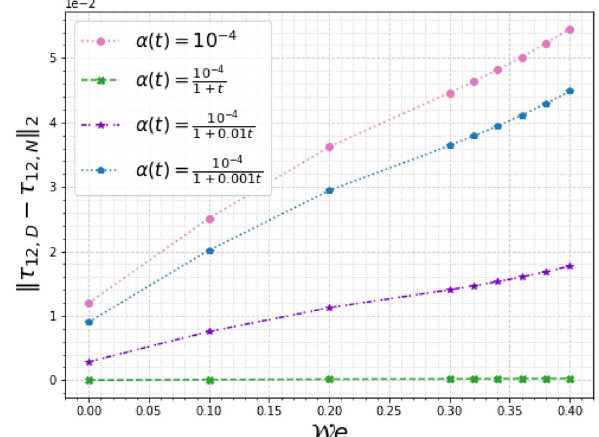
Fig. 11 Comparison of the pressure drop for different values of Fig. 12 Norm of the difference of shear stress component 𝜏 12 parameter 𝜀 of diffusion coefficient 𝛼 ( t ) = 10 − 4 depending on Weis- between the diffusive and non-diffusive model solution, depend- 1 + 𝜀 t senberg numbers W e ing on the Weissenberg number W e , for different values of the